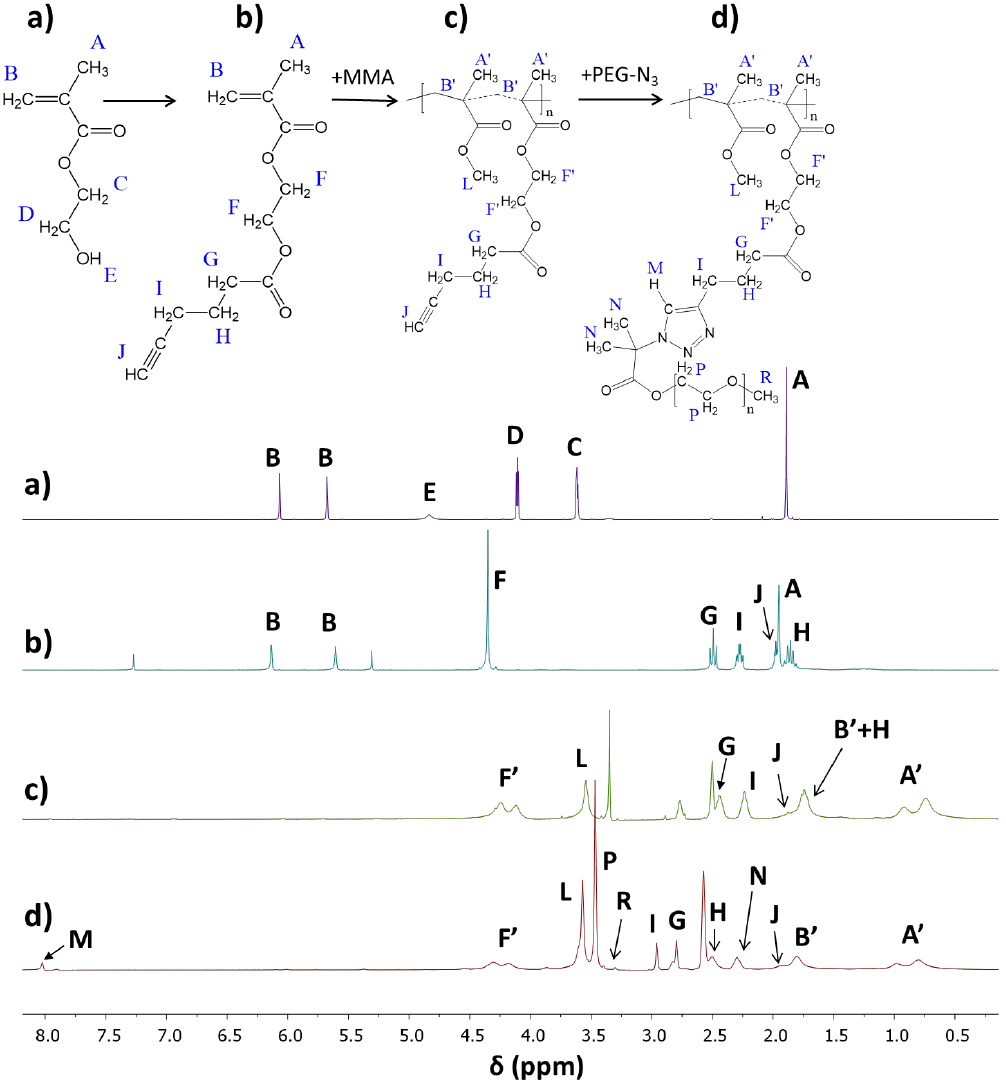
Figure 2. 1 H-NMR spectra of ( a ) HEMA, and ( b ) after its modification AlHEMA, ( c ) P(MMA- co - AlHEMA) V, ( d ) P((AlHEMA- graft -PEG)- co -MMA) Vc. AlHEMA) V, ( d ) P((AlHEMA- graft -PEG)- co -MMA)